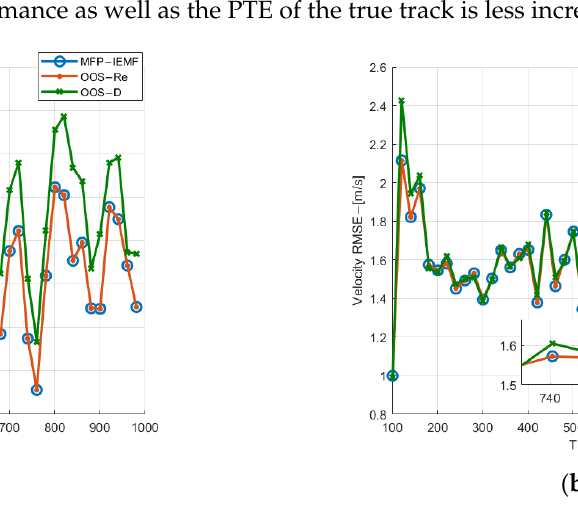
Figure 10. ( a ) Position estimation RMSE of submarine 1 with 5 lags; ( b ) velocity estimation RMSE for submarine 1 with 5